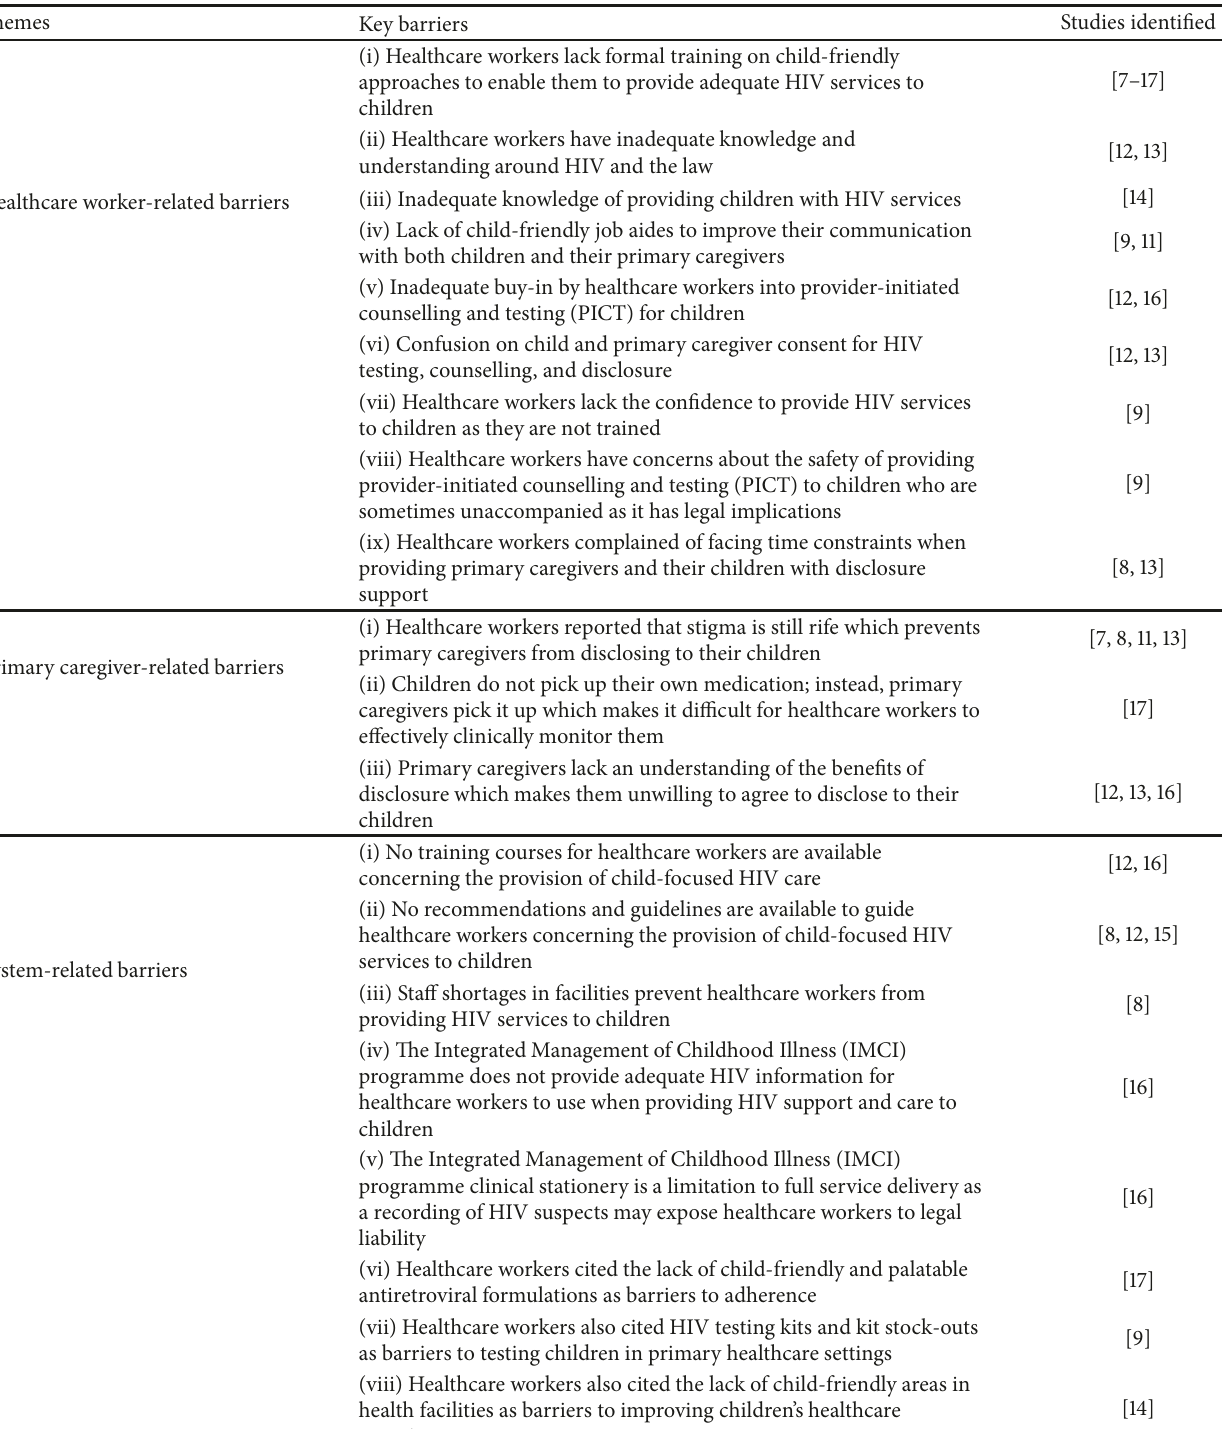
Table 2: A summary of the barriers to providing HIV testing, adherence, and disclosure services to children in Sub-Saharan Africa. Themes Key barriers Studies identified